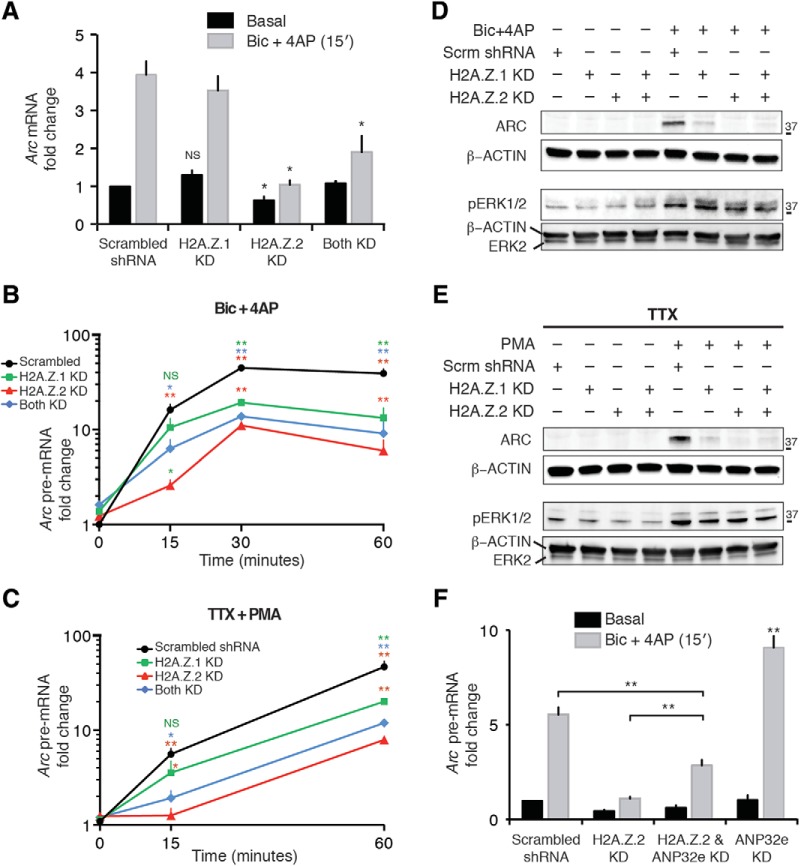
H2A.Z hypervariant-specific RNAi has differential effects on activity-induced Arc transcription. A, Graphical representation of Arc mRNA level at 15 min after treatment with Bic + 4AP in indicated neuronal groups as detected by qPCR and normalized to Gapdh. N = 3–4 for each group; *p < 0.05. NS, not significant. B, C, Representation of Arc pre-mRNA level at different time points after treatment with Bic + 4AP (B) or TTX + PMA (C) in indicated groups of neurons (5–6 d postinfection) as detected by qPCR and normalized to Gapdh. N = 3–4 for each time point; *p < 0.05 and **p < 0.01. NS, not significant. Two sets of data in statistical comparison are represented by the position and the color of asterisk(s) or a NS. For example, in B, the green * on top of the 15 min H2A.Z.2 KD time point (red triangle) represents a statistical difference between the means of H2A.Z.2 and H2A.Z.1 KD group (green square) at the same time point. D, E, Representative Western blottings of whole-cell lysate from neurons infected as indicated for 5–6 d. Neurons were treated with Bic + 4AP (D) or TTX + PMA (E) for either 60 min to detect ARC, or for 15 min to detect phosphorylated ERK1/2. F, Representation of Arc pre-mRNA level at 15 min after treatment with Bic + 4AP in indicated neuronal groups as detected by qPCR and normalized to Gapdh. N = 3; **p < 0.01.